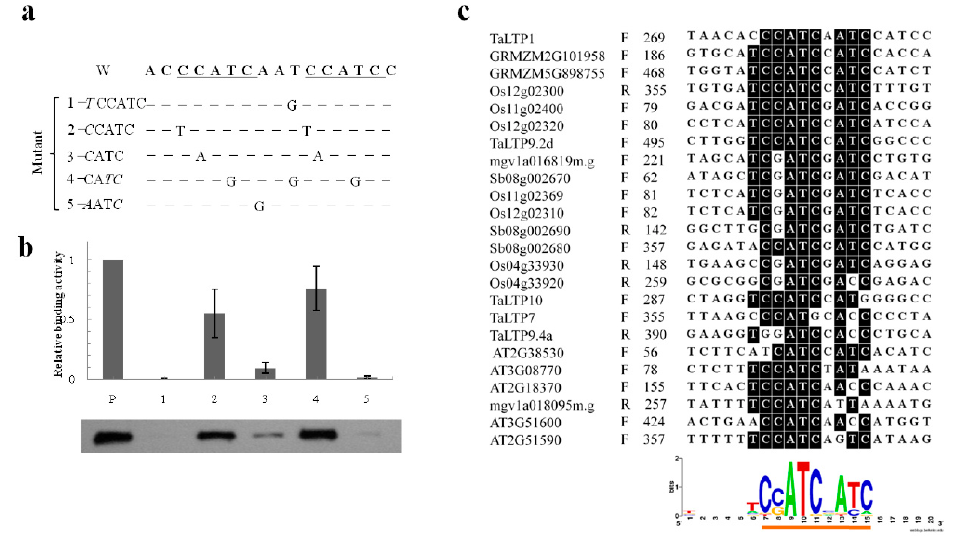
Figure 5. Characterization of the CcATC motif by EMSA using mutated competitors. ( a ) Mutated nucleotides in competitor sequences; ( b ) Relative binding activities in cell extracts when using mutated competitors in EMSA. The band strength was calculated by ImageJ software and was compared with the band formed using probe alone. W, wild type; P, probe. Representative EMSA band patterns when mutated competitors were used are shown below; ( c ) Alignment of CcATC sequences. Conserved nucleotides are shaded. Numbers to the left of the alignment indicate the position of the CcATC with respect to the translation start codon. F, forward strand; R, reverse strand. Sequence logo of the CcATC motif and flanking sequences illustrating conserved nucleotides as taller letters. The CcATC consensus is underlined. The nucleotide sequence logo was created by the WebLogo program (http://weblogo.berkeley.edu/) [33].